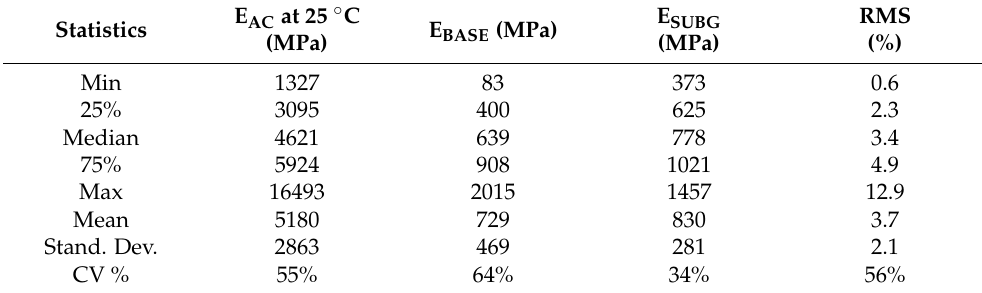
Table 6. Overview of back-analysis results.